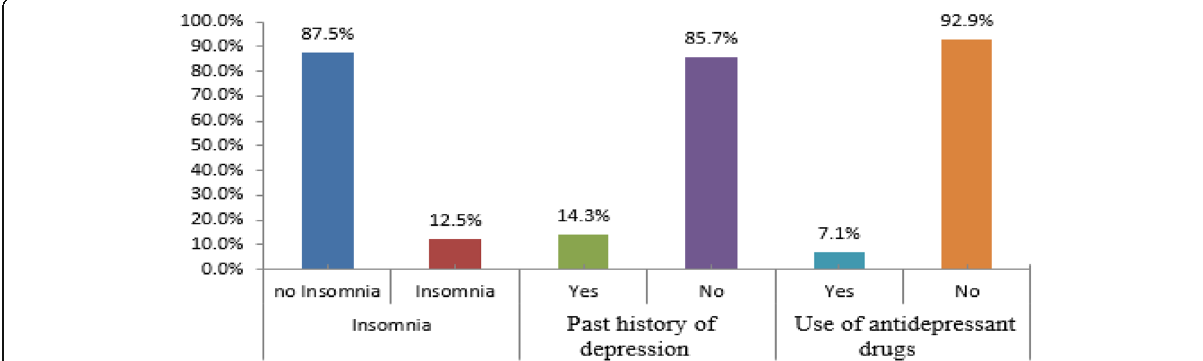
Fig. 1 Distribution of non-depressed patients based on the Insomnia Severity Index. The figure shows that 12.5% had insomnia symptoms, 85.7% had past history of depression, and 92.9 and 7.1% used antidepressant